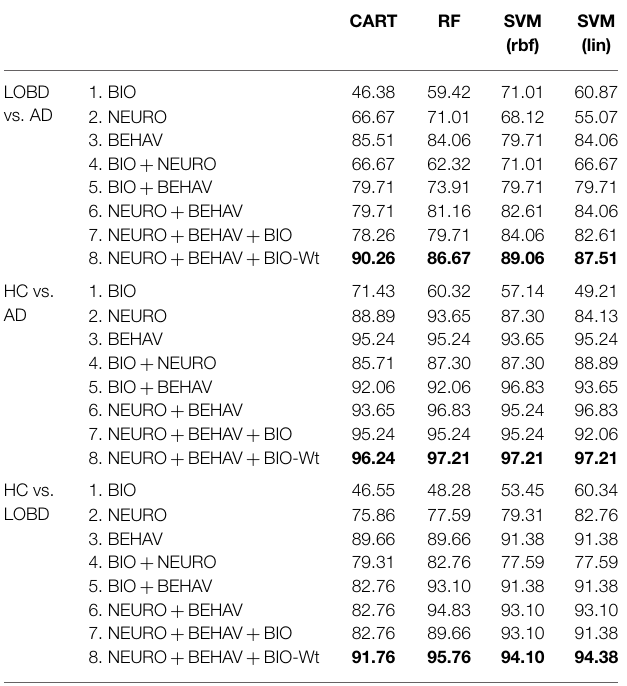
TABLE 4 | LOO AUC estimation of the classifiers on the various combina- tions of features for each classification contrast . CART RF SVM SVM (rbf) (lin)